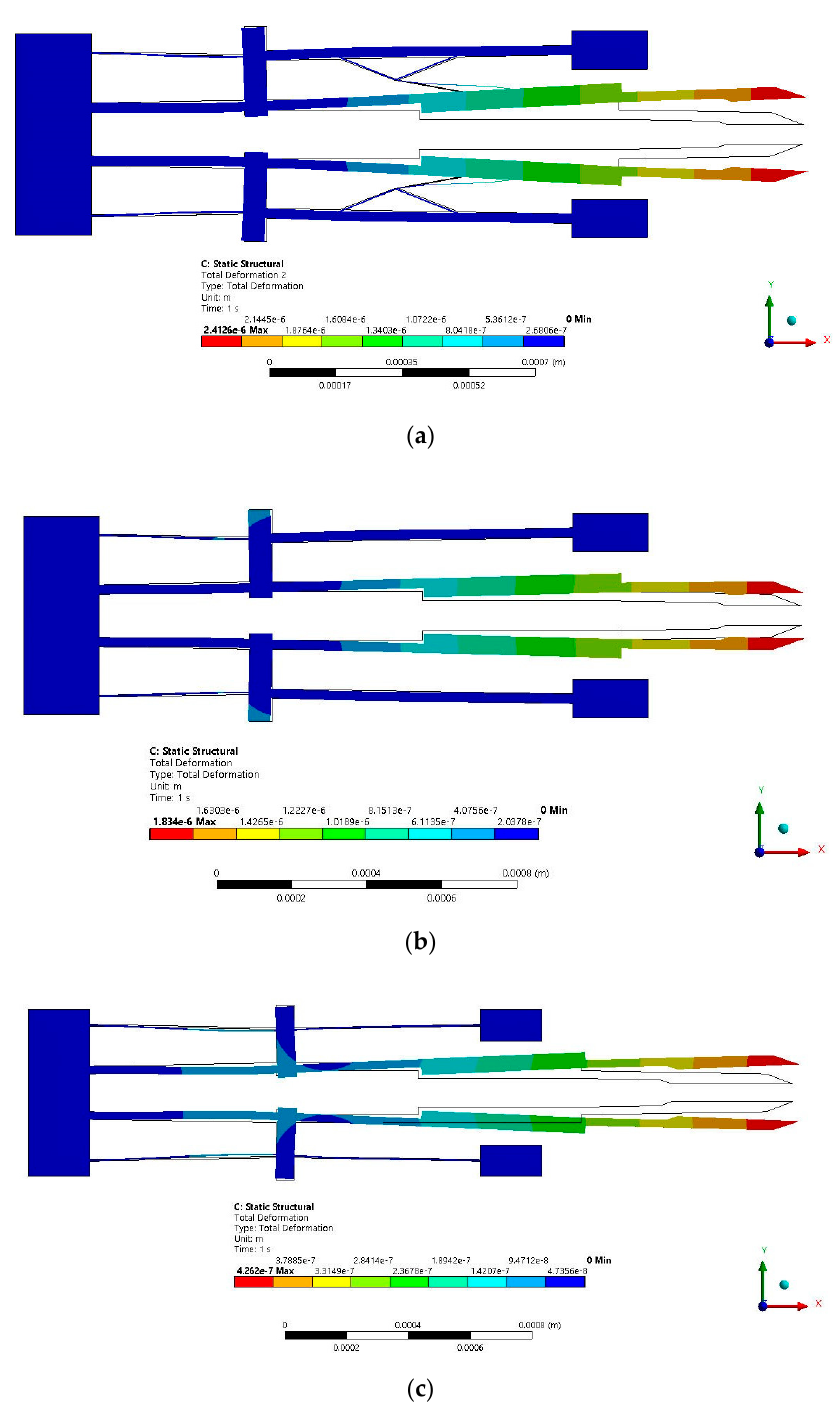
Figure 10. Displacement of microgripper ( a ) with and ( b ) without damping elements. ( c ) Displace- ment of microgripper with a V-shaped actuator.